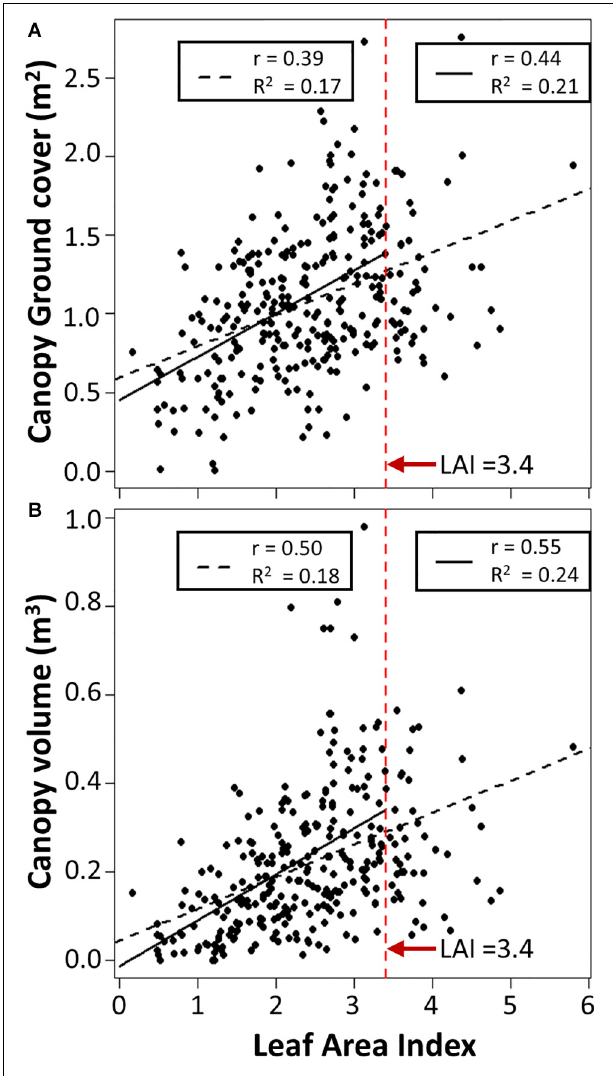
FIGURE 7 | Relationship between Leaf Area Index and computed (A) Canopy ground cover and (B) Canopy volume for all observations (dashed black line, n = 291) or when observations with LAI above 3.4 are discarded (solid black line, n = 251). r is the Spearman’s rank correlation, R 2 is the adjusted R 2 . All statistical tests have a p <